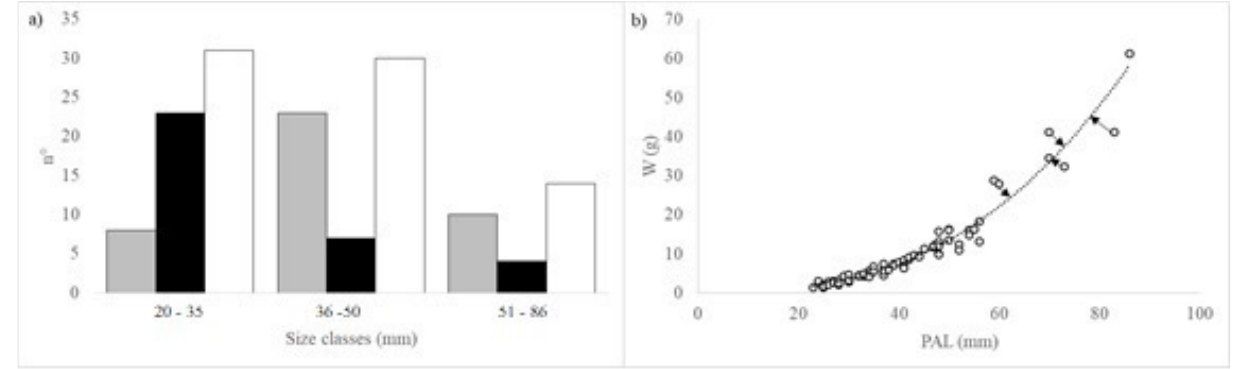
Table 1. Taxonomical details of prey found in a sample of Coelorinchus caelorhincus seasonally collected in the bathyal slope of the Central Tyrrhenian Sea. Different text indentation and prey items in bold (and corresponding abundance as number) indicate different levels of taxonomical identification and taxonomical units used for the statistical analyses, respectively.